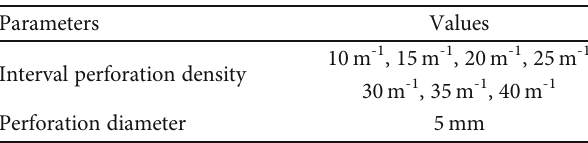
Figure 7: In fl ow rate distribution of completion with uniform perforation density at di ff erent times. Table 3: Parameters of completion with di ff erent perforation